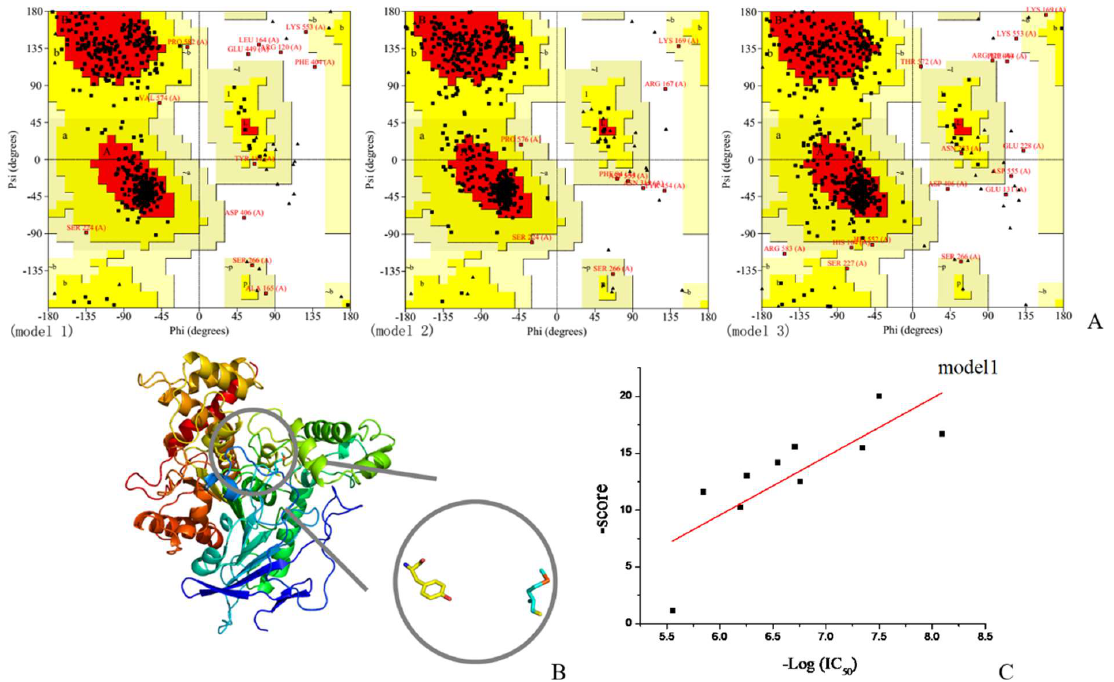
Figure 1. Fitted curve of the most appropriate models. ( A ) Ramachandran plots of three models, ( B ) model 1 which was chosen for further studies, and ( C ) scatter plot and standard curve based on docking scores and IC 50 .